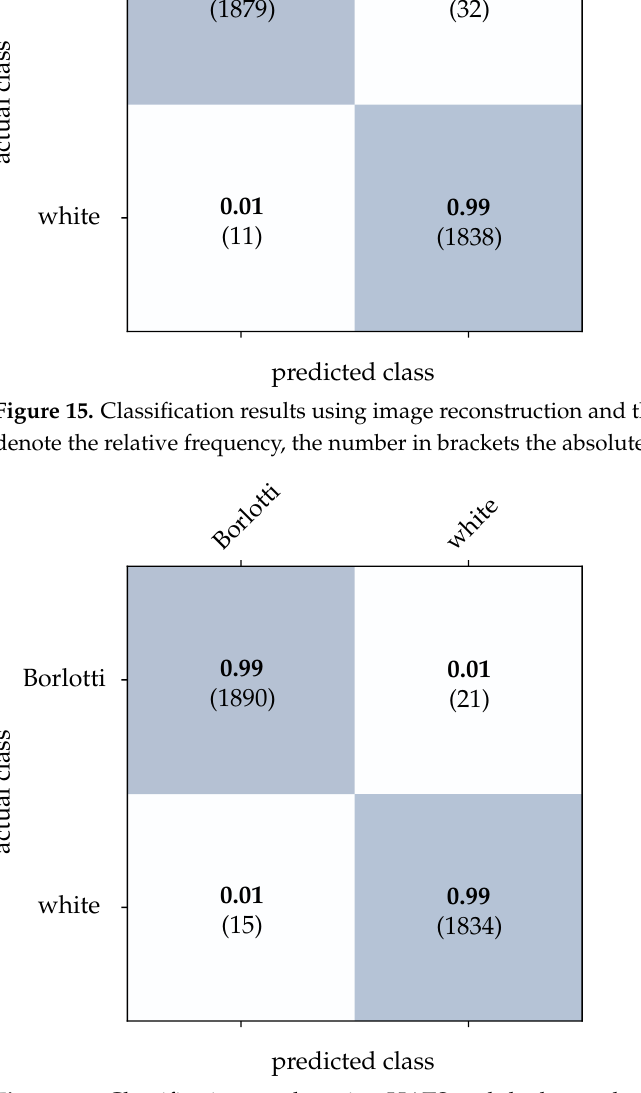
Figure 16. Classification results using HATS and the beans dataset. The bold values denote the relative frequency, the number in brackets the absolute number of